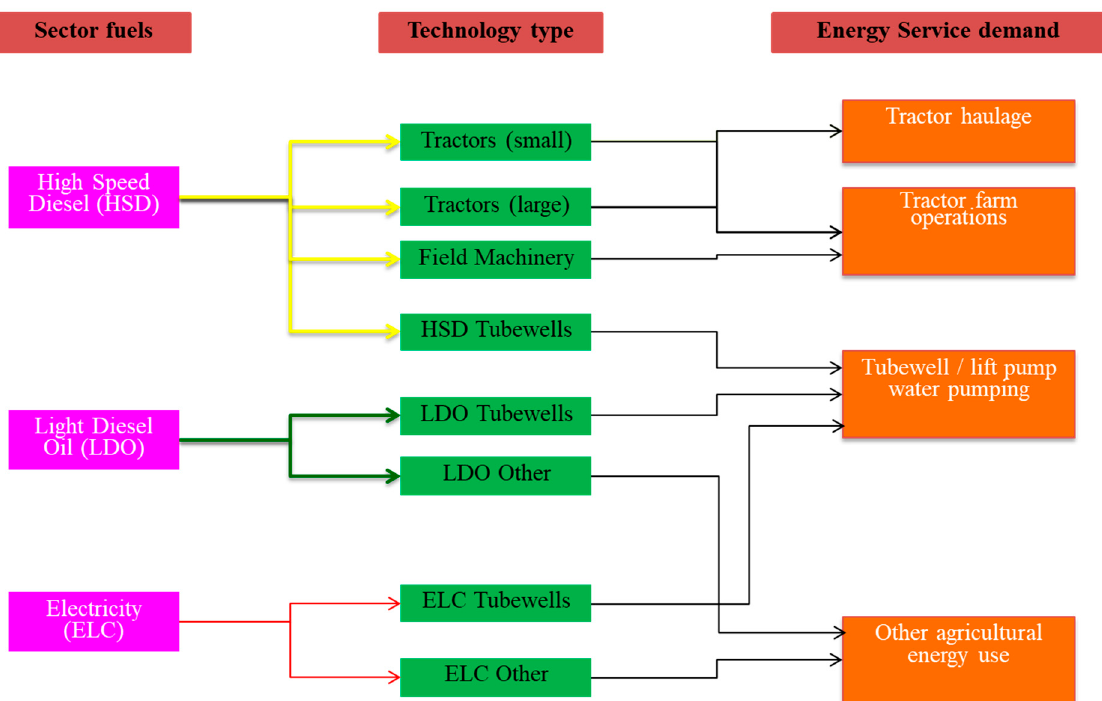
Figure 9. Energy flow across the agriculture sector in Pakistan .